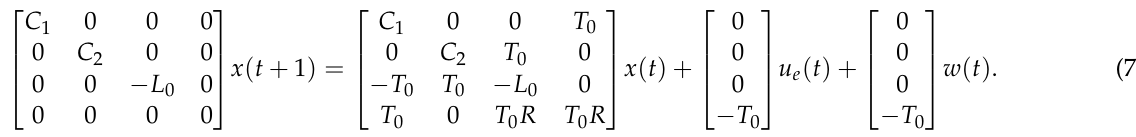
( d ) Figure 4. Filtering error variances of local filters with and without feedback for sensor 1. ( a ) The first state component. ( b ) The second state component. ( c ) The third state component. ( d ) The fourth state component. Example 2. Consider the circuit system measured by three sensors shown in Figure 5, where the voltage source e u is the control input. It is effected by white noise ( ) w t due to the equipment installation, circuitry interference and voltage fluctuation. For R ,